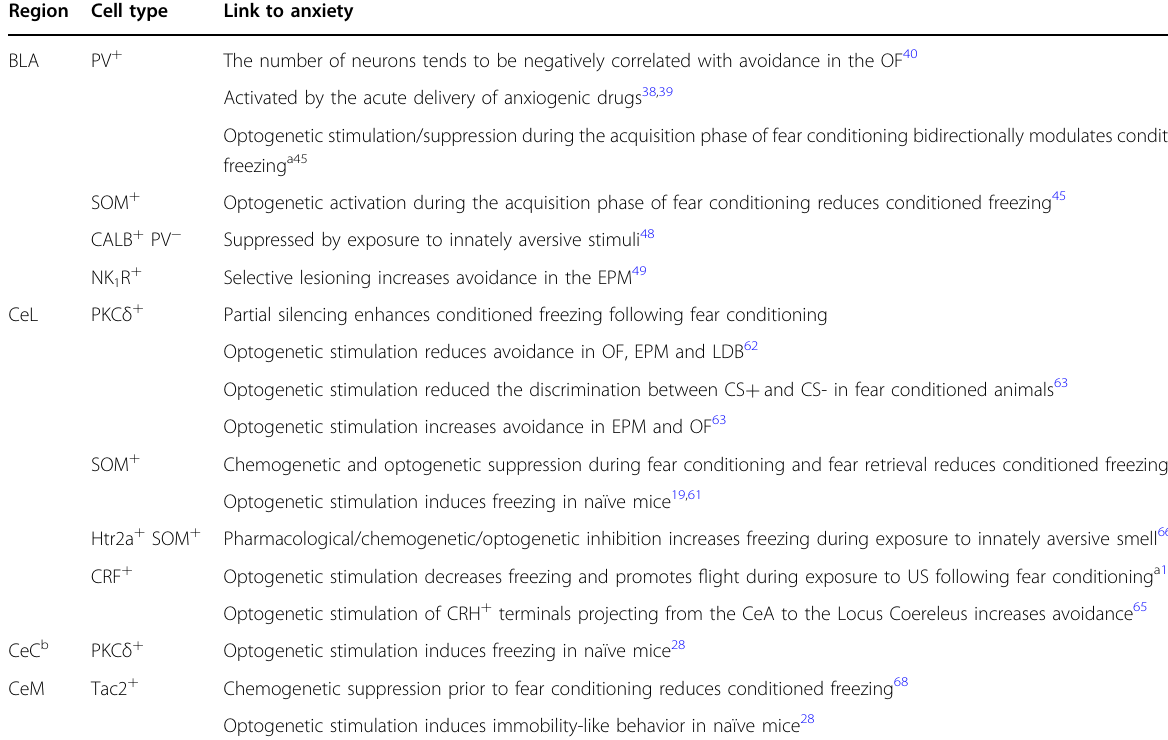
Table 1 Inhibitory neurons in the basal and central amygdala that are linked to the regulation of anxiety-related